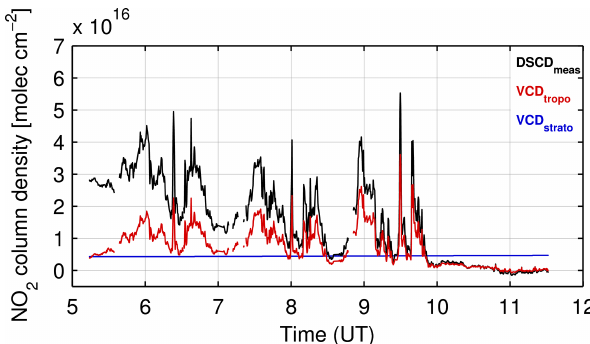
Figure 10. Time series of NO 2 DSCD meas (black), VCD tropo (red), and VCD strato (blue) obtained from car DOAS zenith-sky spectra recorded on 10 April